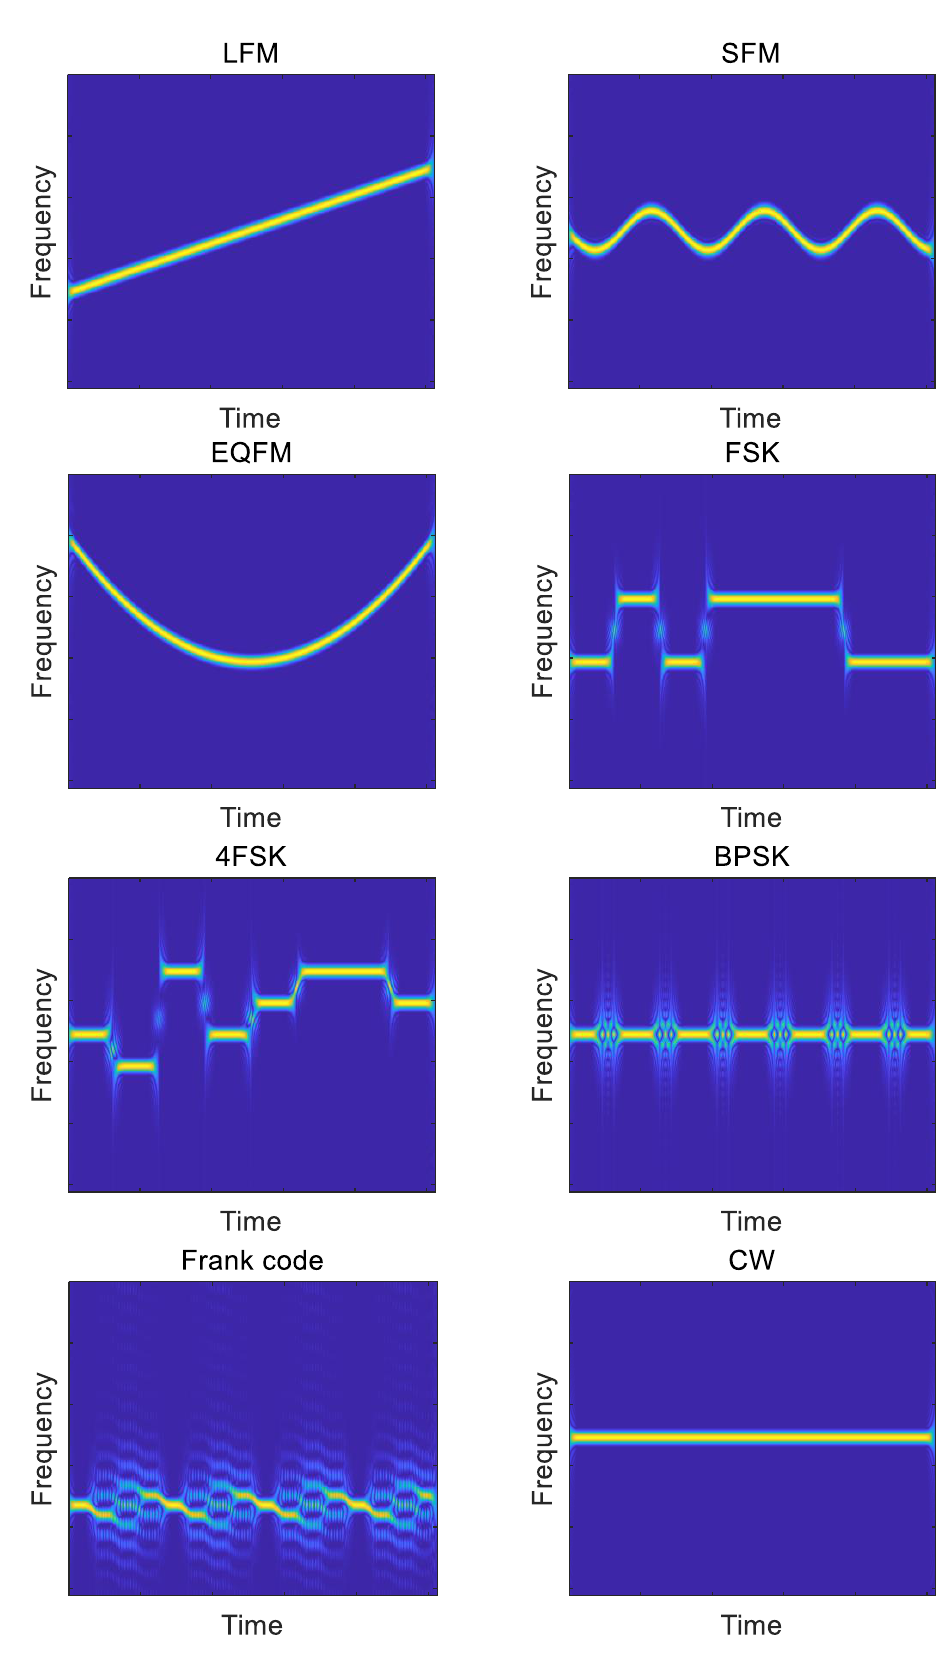
Figure 1. The TFDIs of 8 typical radar